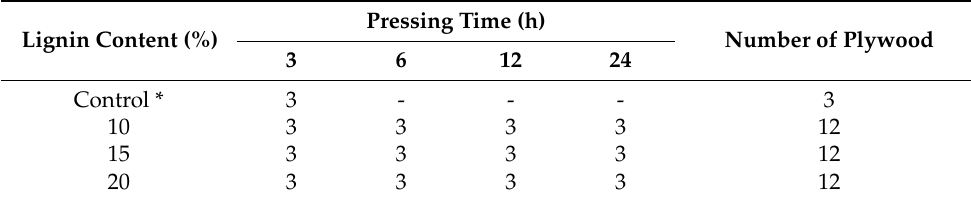
Table 2. Fabrication of plywood bonded with PVOH–lignin–hexamine-based adhesive at different lignin contents.